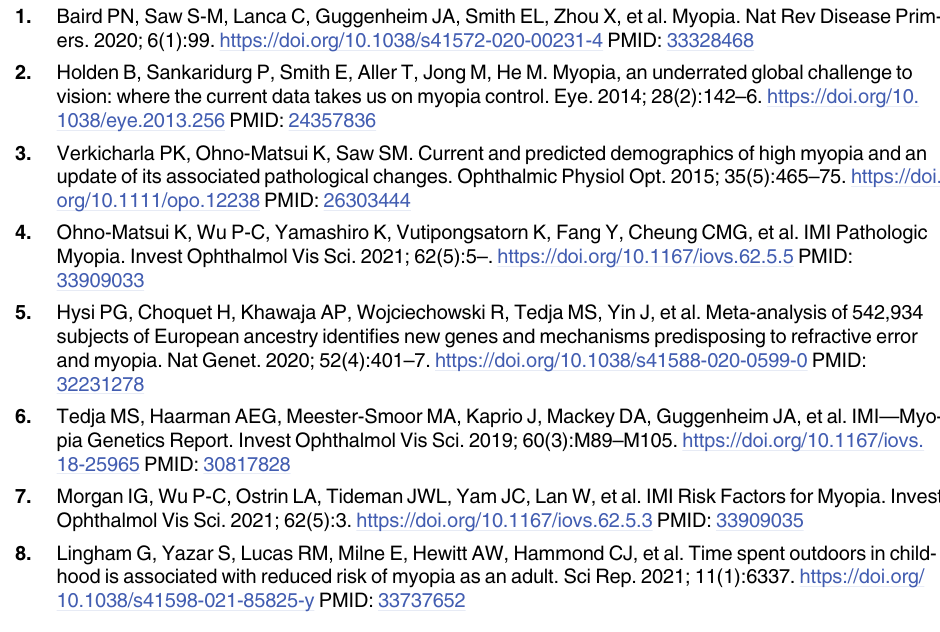
(AOSW) as a surrogate for refractive error (avMSE) in GxE interaction tests. Box D in S1 Text . Comparison of results of sensitivity analyses. Box E in S1 Text . Supplementary Methods. Fig A in S1 Text . Manhattan plot of the results from the GWAS for refractive error (avMSE) in the Stage-I sample. Fig B in S1 Text . SNP genotype by University education (GxE) interac- tions associated with age-of-onset of spectacle wear (AOSW). Fig C in S1 Text . Summary of the evidence for SNP × SNP interactions contributing to myopia development.